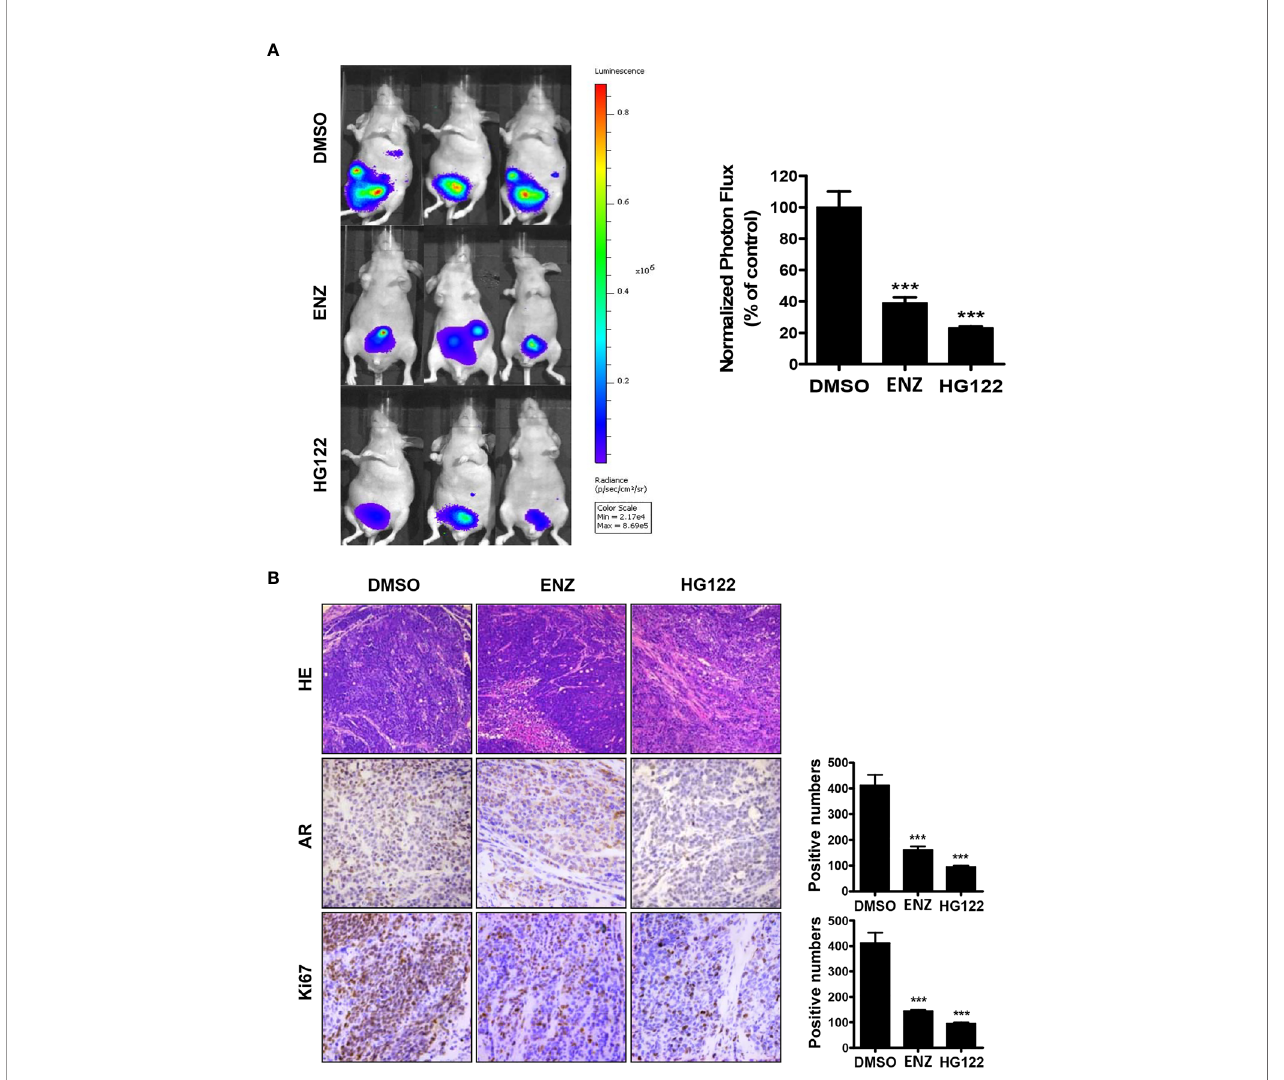
FIGURE 6 | Therapeutic effects of HG122 on orthotopic castration-resistant xenograft model. (A) Bioluminescent analyses of orthotopic prostate tumors treated with HG122, ENZ, or vehicle control. Tumors were imaged every week to observe local tumor growth and evidence of tumor cell dissemination. Representative images of three mice per group are illustrated (n = 5). ***P < 0.001. (B) Ki67, AR immunohistochemistry, and the structural changes in tumor were analyzed. Photographs of representative tumor sections were taken at ×200 magni fi cation (n = 4; ***P <